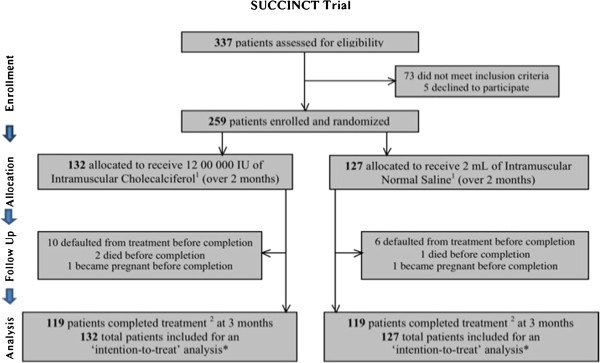
Study Flowchart. Study Drug (Cholecalciferol) and Placebo (Normal Saline) matched for colour and volume of contents. 2 ‘Completed treatment’; administration of 2 doses of study drug/placebo (over first 2 months), with follow up assessments complete at all visits over a total duration of 3 months. * Includes all patients who completed treatment at end of 3 months, as well as those who died during, or defaulted from, treatment before completion (indicated for each treatment arm). Flow Diagram adapted from the CONSORT 2010 Statement: updated guidelines for reporting parallel group randomized trials.